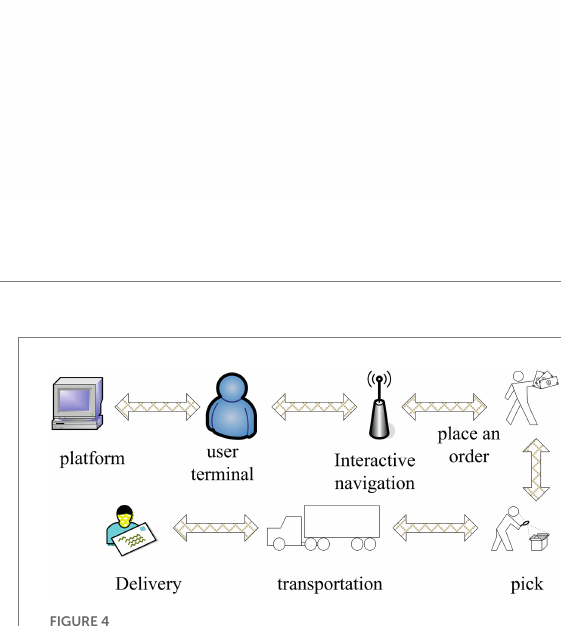
FIGURE 4 Distribution business structure of logistics express